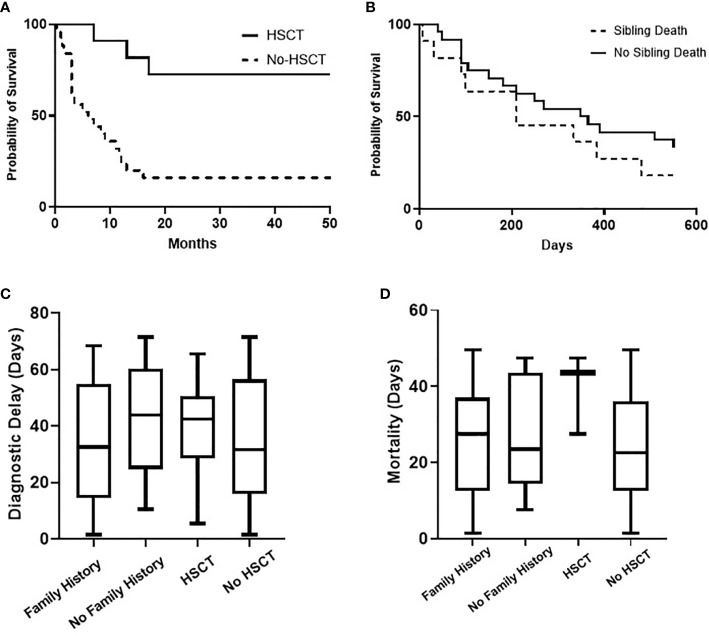
Overall probability of survival (Kaplan-Meier curve) of children with SCID for HSCT (P value = 0.0003) and for the presence of sibling death (P value = 0.2923), (A, B). Comparative analysis (Kruskal-Wallis test) for diagnostic delay (P value = 0.5702) and mortality age (P value = 0.3427) in relation to family history and HSCT, (C, D).